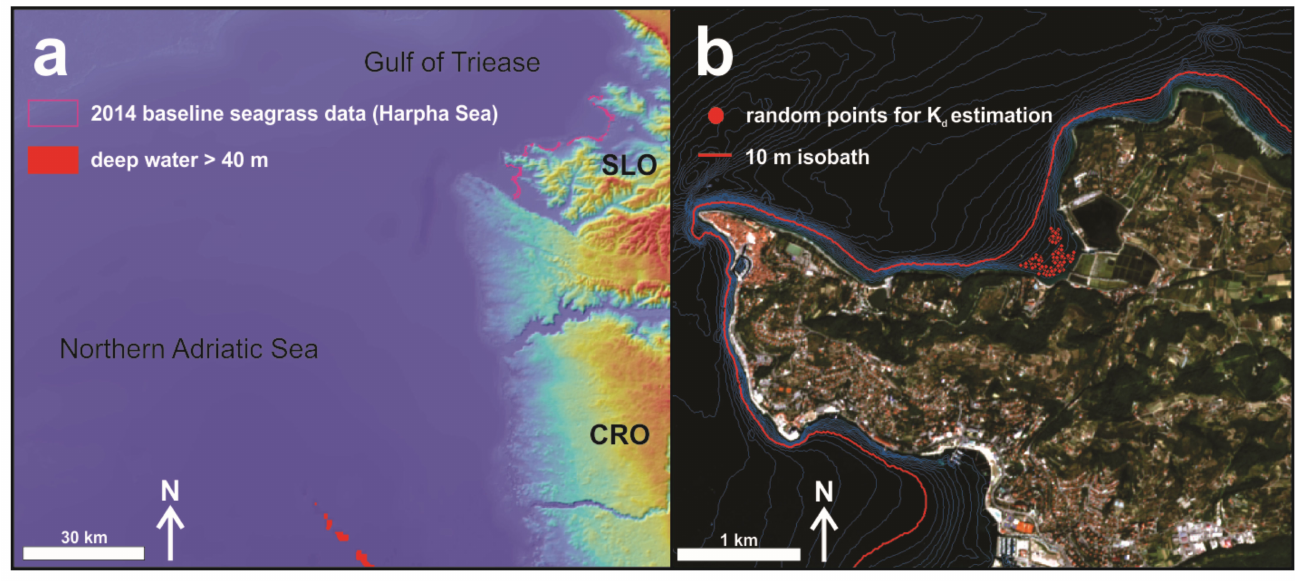
Figure 2. Identified pixels for infinitely deep-water reflectance estimation ( a ) and the location of random points for diffuse attenuation coefficients determination ( b